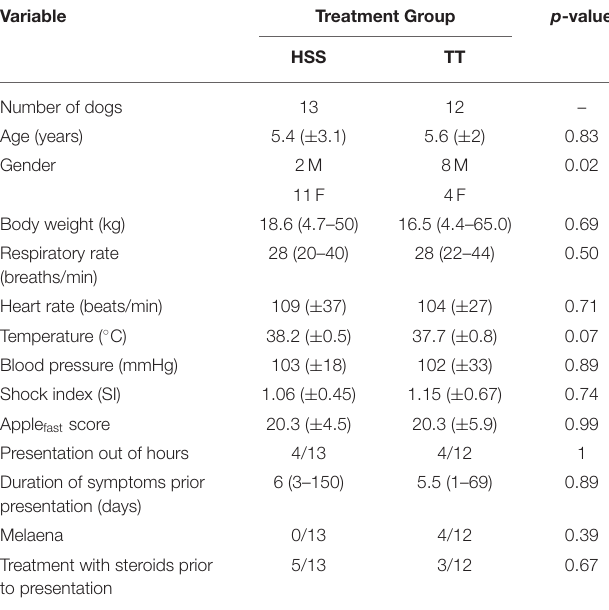
TABLE 1 | Comparison of baseline characteristics including signalement, history, physical examination, and illness severity scores between dogs treated with hydrocortisone CRI (HSS group; n = 13) and dogs treated with prednisolone/dexamethasone (TT group; n =